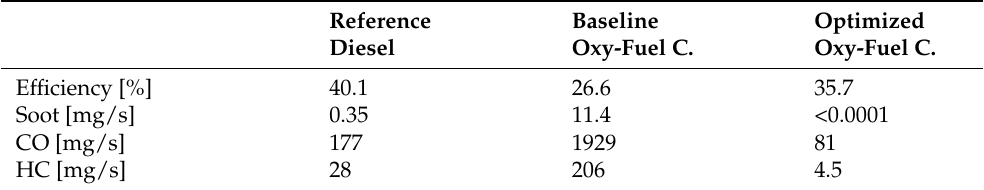
Table 9. Comparison between the efficiency, soot, and CO between the reference Diesel case, baseline and optimized oxy-fuel combustion